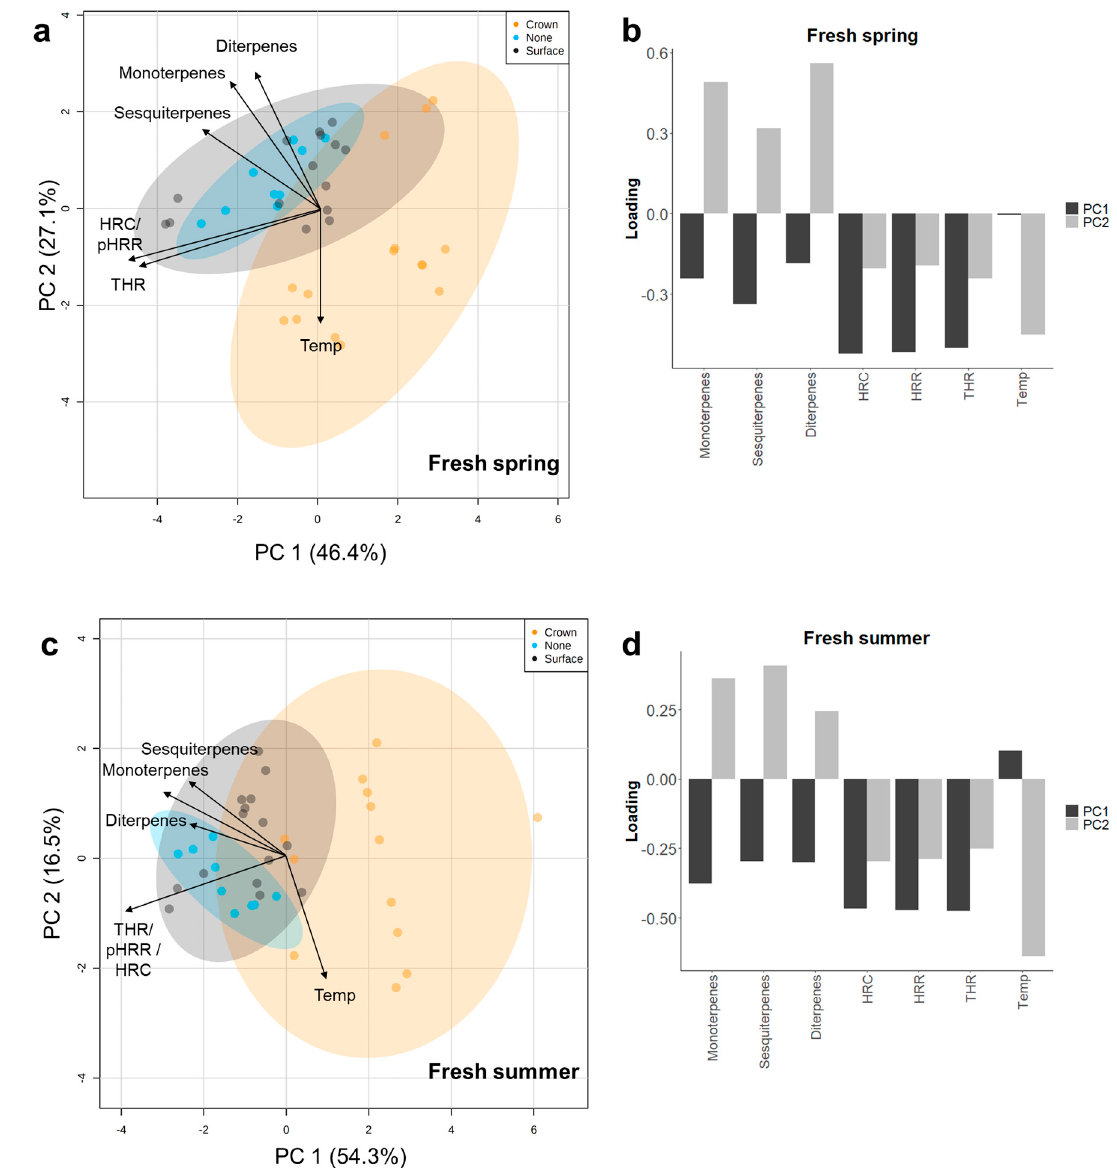
Figure 6. Principal component analysis (PCA) of flammability traits in fresh needles ( a – d ). Principal component analysis of the terpene content and flammability characteristics of fresh pine needles, sampled in spring ( a ) and summer ( c ). Crown-fire species are represented in orange, surface-fire in grey and none-fire in open circles. Each point represents an individual replicate, with three replicates per species, and 95% confidence intervals for each fire regime are shown with ellipses. The contribution of individual factors to the first two principal components are indicated with labelled arrows ( a and c ) and are shown in ( b ) for spring data and ( d ) for summer data.